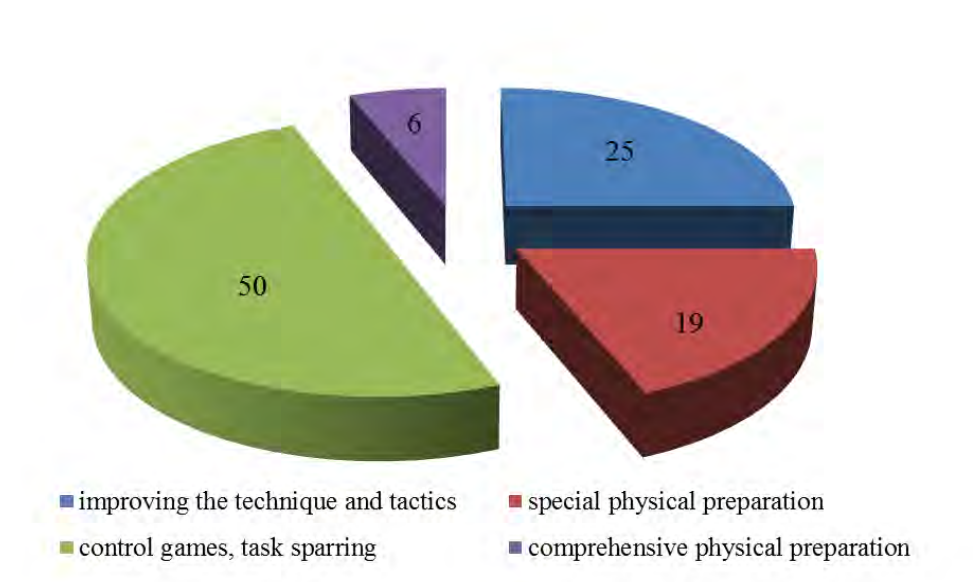
Fig.. 3 Proportions of training means in the supercompensation phase,